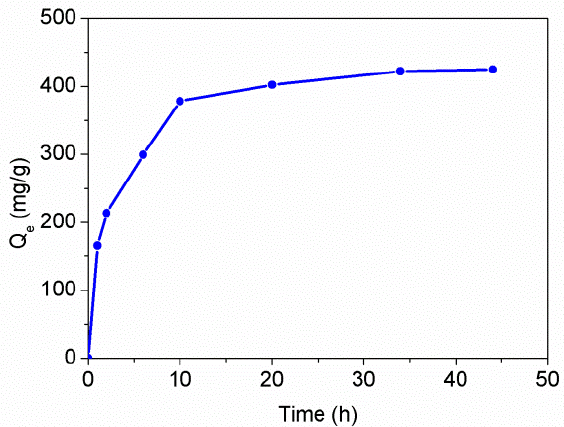
Figure 12. The adsorption kinetics behavior of PAT-PS particles for Hg(II) in aqueous solution (PAT-PS 20 mg, C 0 = 500 mg/L, pH 4.5).